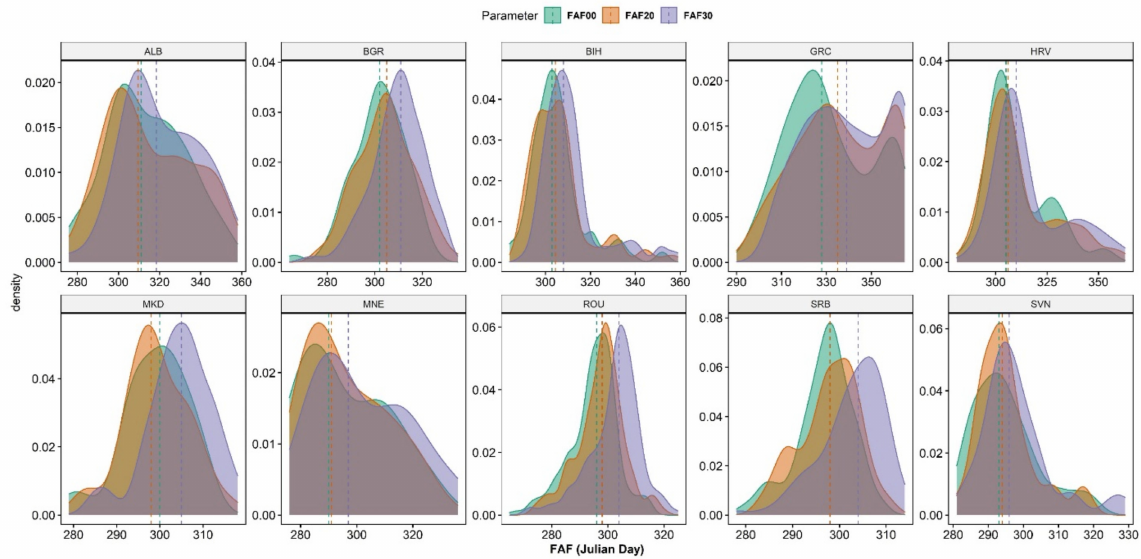
Figure 9. The density plots of the First Autumn Frost (FAF) Julian day for the reference period and the 2020 and 2030 horizons, per country. The vertical lines represent the median